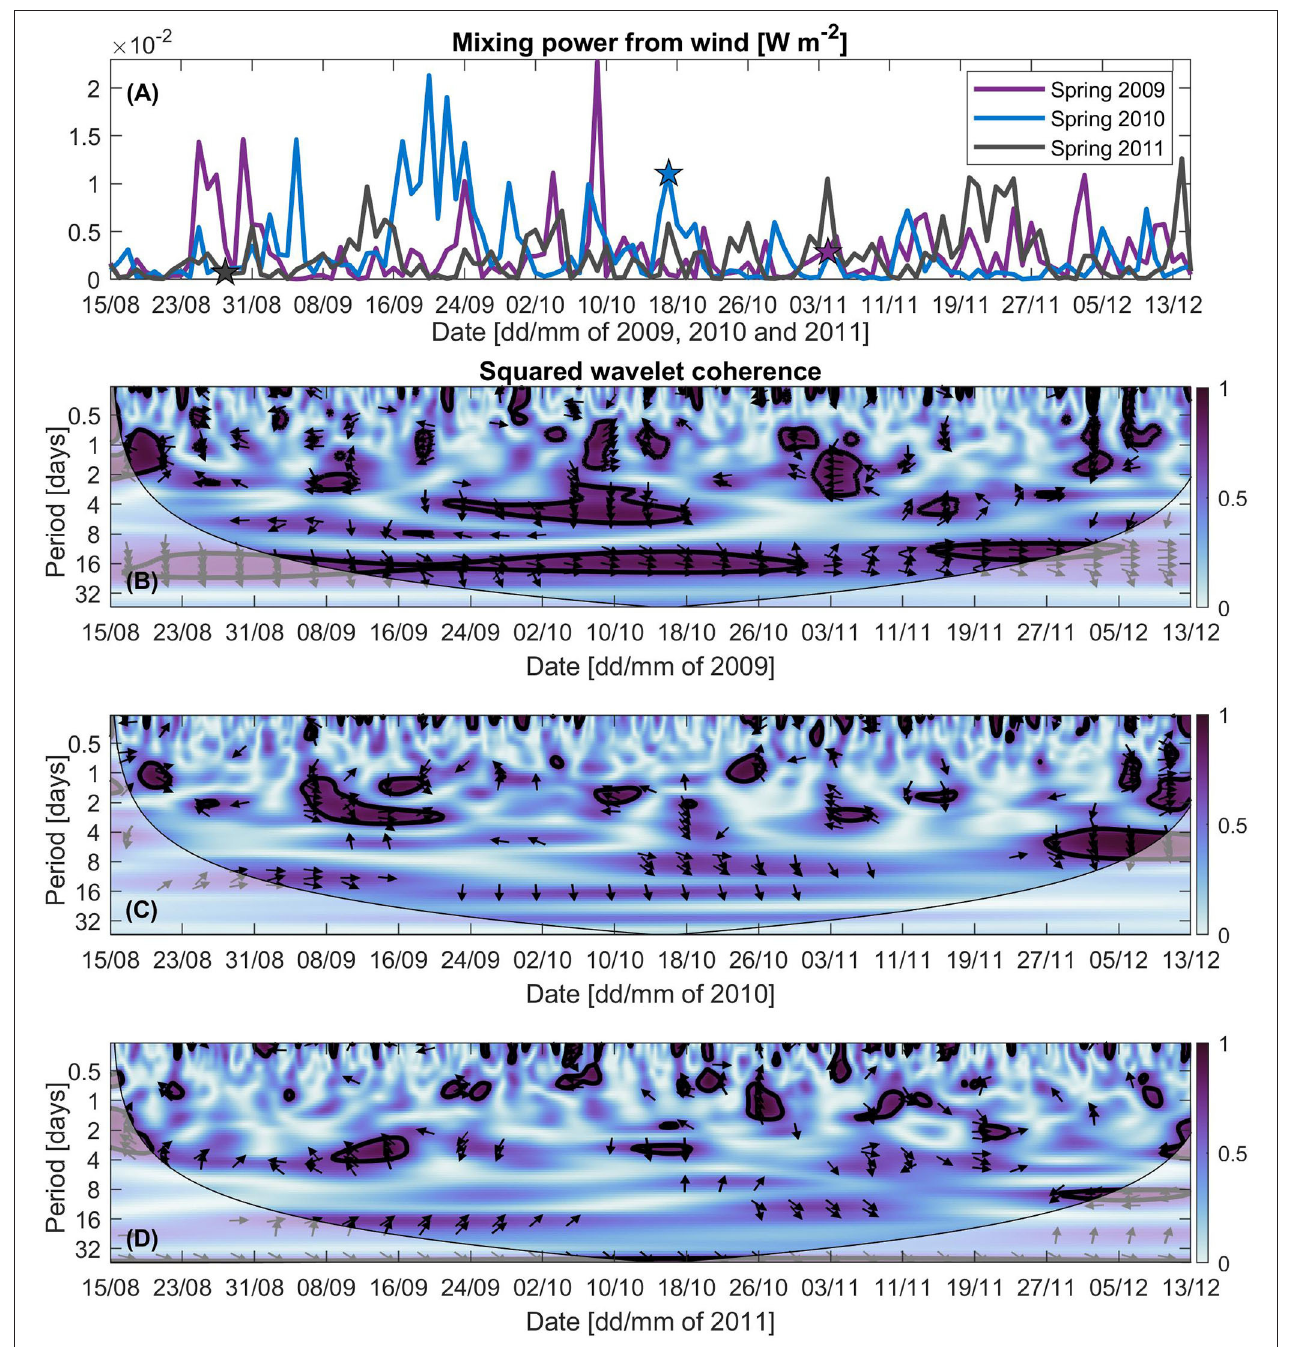
FIGURE 9 | (A) Mixing power from wind for springs 2009 (purple), 2010 (blue), and 2011 (gray), calculated across yellow transects indicated on Figure 8 . (A) Stars indicate wind mixing power on dates of analyzed modeled case studies in each spring. Time series Wavelet transform coherence squared of surface V-momentum wind stress and surface salinity near the opening of Golden Bay for springs (B) 2009, (C) 2010, and (D) 2011. The cone of influence (Torrence and Compo, 1998) where discontinuities at end points occurred because of padding with zeros and may cause distortion of the results are indicated by the lighter shade. Thick black contour indicates 95% confidence level, using red noise as background spectrum. The arrows indicate the relative phase relationship, with in-phase pointing right, anti-phase pointing left, and wind stress leading salinity by 90 ◦ pointing straight down. The time axes for each spring are consistent with those in Figure 6 . were found occurring at similar periods on other dates, such as ( Figure 9B ). This implies that winds induce the advection of low in mid-August 2009, beginning of September 2009 ( Figure 9B ), salinity water during that period as the two time series are in anti- beginning of November 2010 ( Figure 9C ), and phase over a period of 1–5 days. Significant coherence patterns